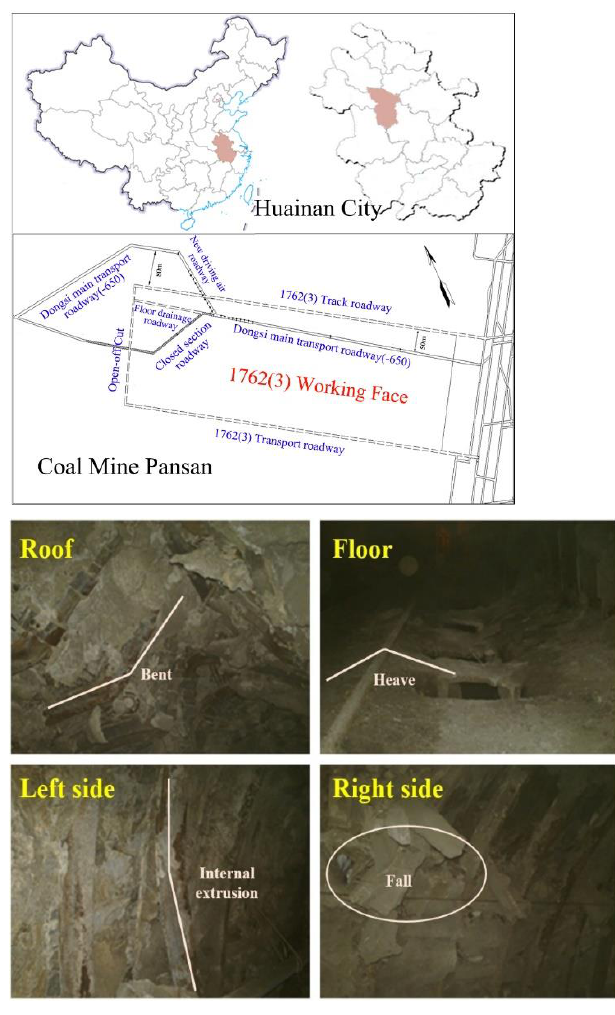
Figure 2. Mine general situation and roadway deformation.